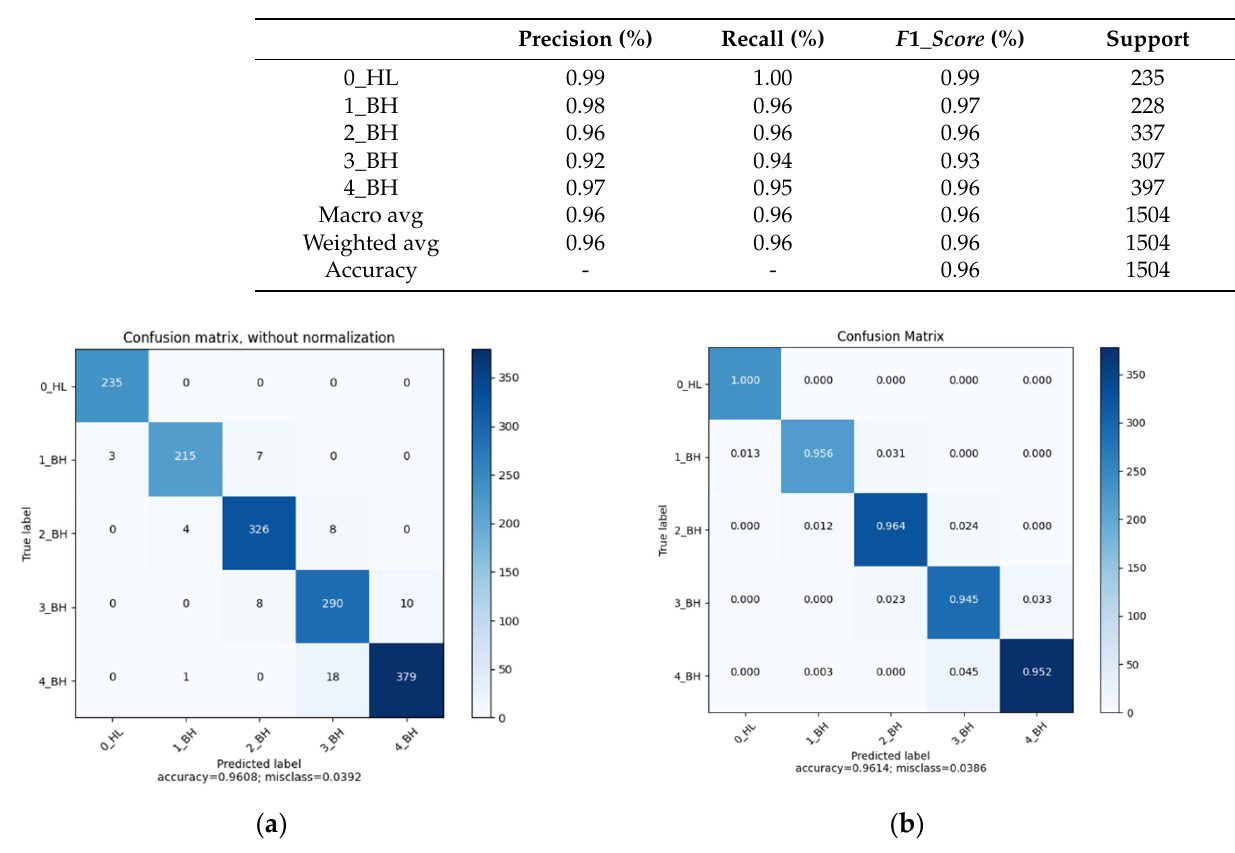
Figure 12. Confusion matrix of DISE-Net. ( a ) Confusion matrix without normalization. ( b ) Nor- malized confusion matrix. Table 6. Classification report.